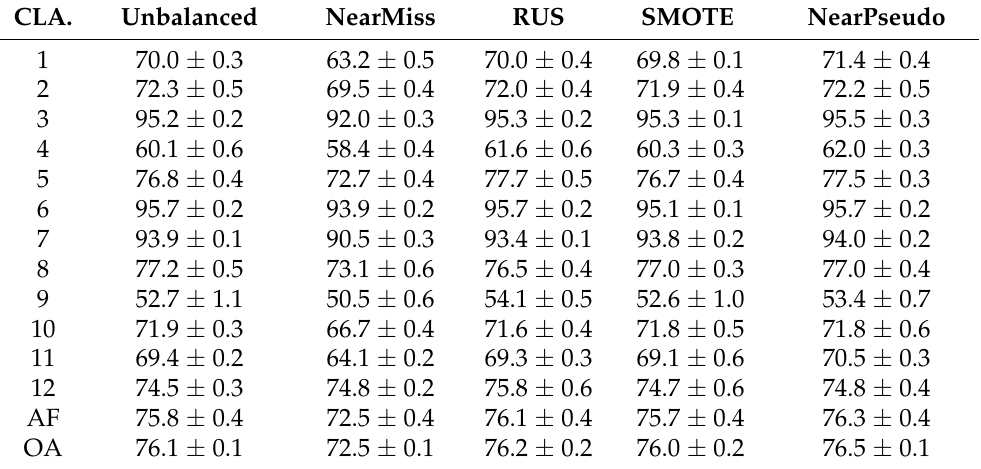
Table 4. Classification accuracy (%) of different solutions on sub-training data T3